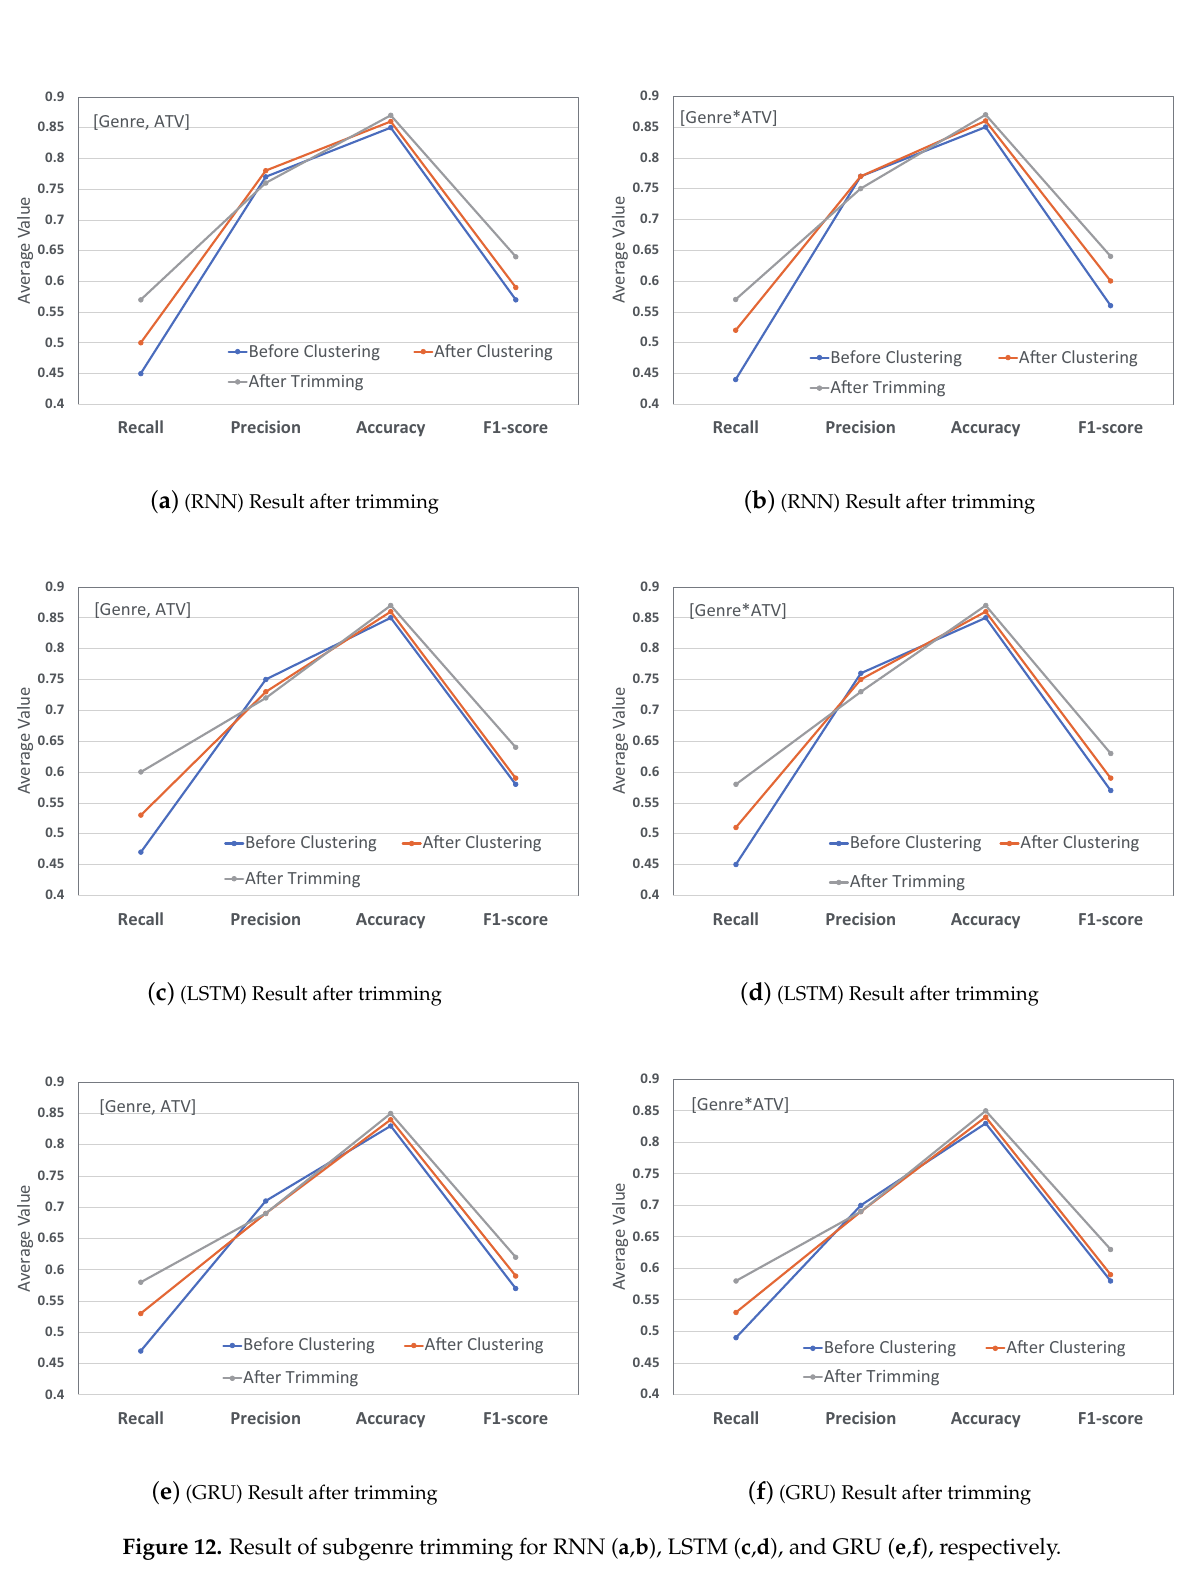
Figure 12. Result of subgenre trimming for RNN ( a , b ), LSTM ( c , d ), and GRU ( e , f ),